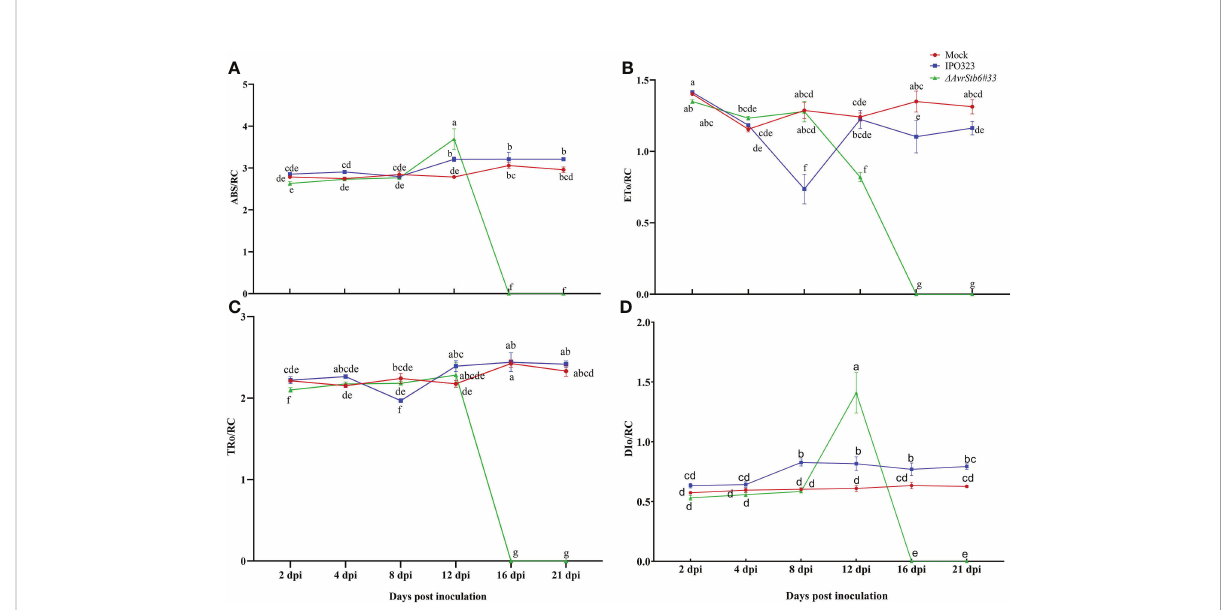
FIGURE 3 AvrStb6-Stb6 interaction impacts ABS/RC (A) , ET 0 /RC (L688) (B) , TR 0 /RC (L688) (C) , and DI 0 /RC (L688) (D) H 2 O 2 (L897)parameters. The WT IPO323 and D AvrStb6#33 strains were applied to infect the leaves of cv. Sha fi r harboring the Stb6. The Fluorpen FP instrument was used